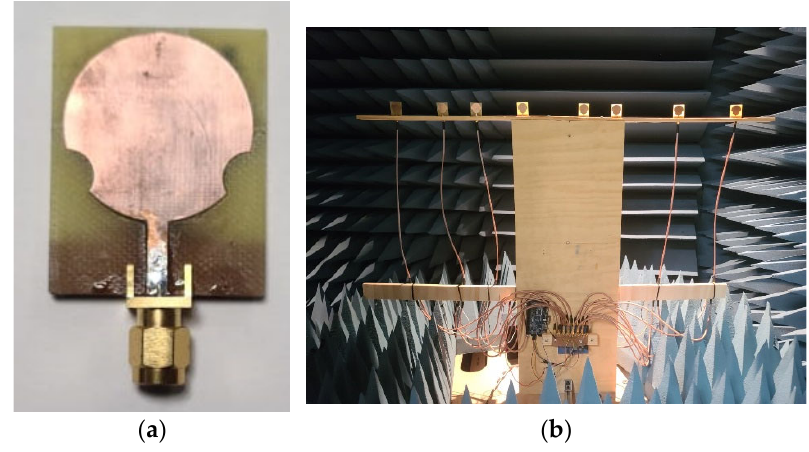
Figure 8. Prototype design: ( a ) single antenna element; ( b ) non ‐ uniform array.